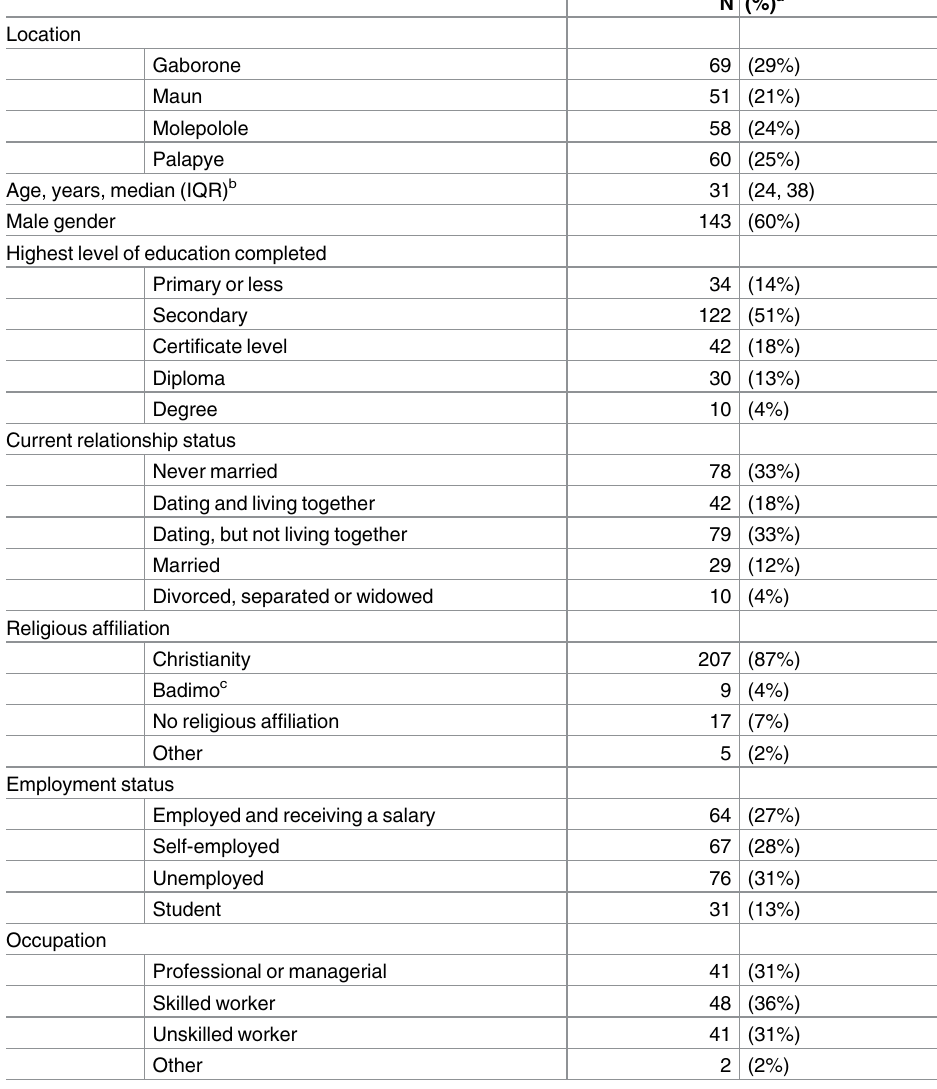
Table 1. Descriptive characteristics of 238 men, women, and community leaders who participated in 27 focus group discussions across four communities in Botswana.